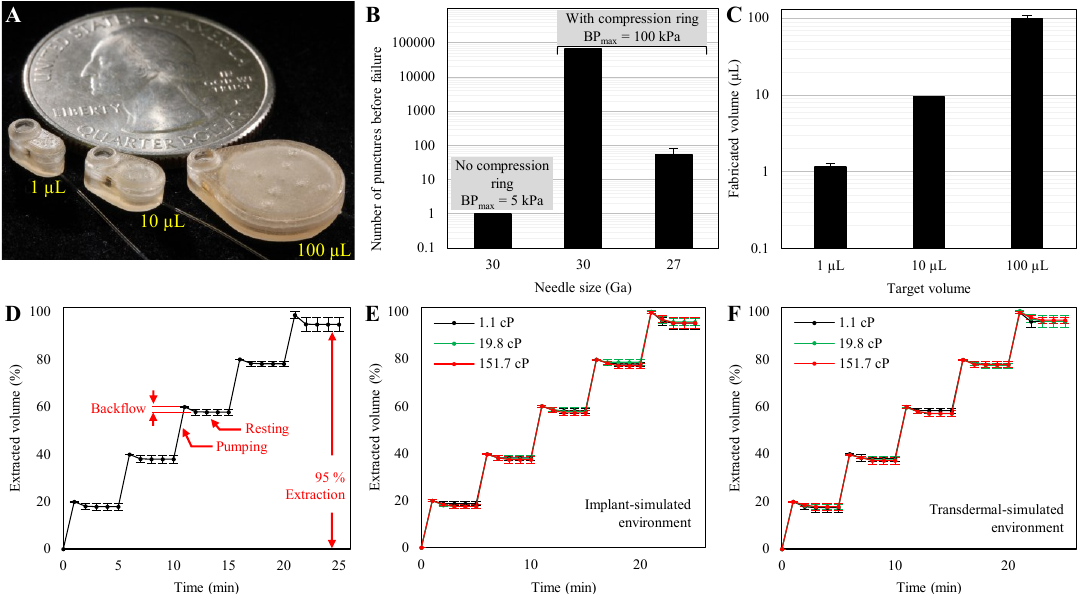
Figure 6. ( A ) Completed microreservoirs with capacities of 1, 10, 100 µ L, showing the scalability of the design and fabrication process. ( B ) Septum characterization results showed that the samples without compression rings leaked at less than 5 kPa applied backpressure with just one puncture with a 30 Ga needle. Adding a compression ring to the septum cap increased the number of punctures before failure to ~65,000 at 100 kPa backpressure when puncturing with a 30 Ga needle. This design showed no leakage up to 55 injections at 100 kPa backpressure when punctured by a 27 Ga needle. N = 4, mean ± SD. ( C ) Fabricated volumes were 1.15 ± 0.12, 9.63 ± 0.12, and 100.04 ± 9.43 for target volumes of 1, 10, and 100 µ L. N = 4, mean ± SD. ( D ) The average results of the backward flow due to the restoring force for capacities of 1, 10, and 100 µ L normalized by the total volume of each. The results showed zero forward flow and insignificant backward flow (2.02% average), which occurred quickly ( < 2 min) after pneumatic pressure release, suggesting long-term stable behavior of the storing membrane. The last step of the experiment shows the total extraction percentage, which was 95% of the capacity. N = 9, mean ± SD. ( E ) The results of in vitro experiments for implantable drug delivery on fully integrated 10 µ L microreservoirs with a drug model of 1.1 cP showed an average backflow of 1.69%, indicating that the microreservoir can fully operate in a subcutaneous implant environment. Further, using drug models with viscosities of 19.8 and 151.7 cP showed 1.98% and 2.59% average backflow, demonstrating that the microreservoir can work regardless of the drug viscosities up to ~7.5 times greater than those of typical injectable drugs for implantable drug delivery. N = 3, mean ± SD. ( F ) Results of in vitro experiments for transdermal drug delivery on fully integrated 10 µ L microreservoirs with a drug model of 1.1 cP show an average backflow of 2.06%, indicating the suitability of the device for transdermal drug delivery. The results of drug models with viscosities of 19.8 and 151.7 cP showed 2.24% and 2.33% average backflow. This shows proper functionality of the device independent of drug viscosity for transdermal drug delivery. N = 3, mean ±